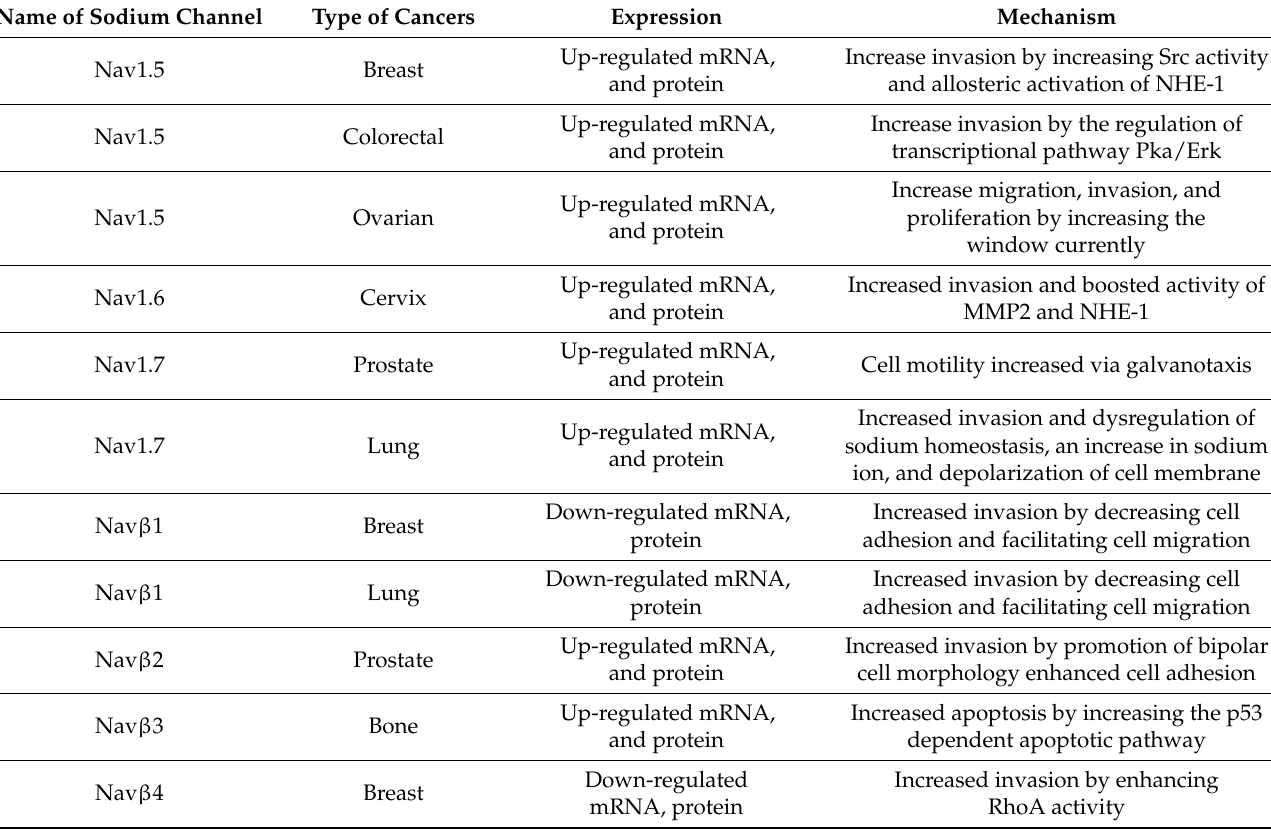
Table 1. Role of various sodium channel subunits in different types of